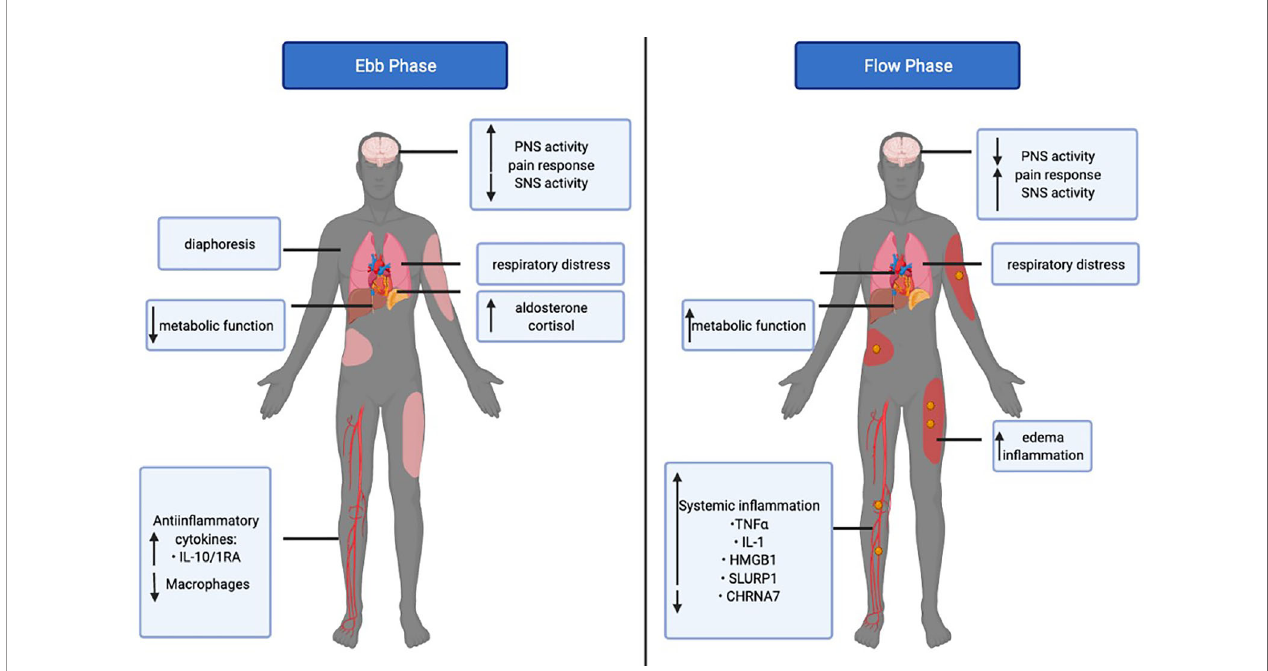
FIGURE 1 | The bi-directional communication between the central nervous system (CNS) and the spleen. The parasympathetic nervous system (PNS) uses acetylcholine and the vagus nerve to decrease burn-induced in fl ammation via the spleen. The sympathetic nervous system (SNS) uses norepinephrine and the hypothalamus, pituitary, and adrenal axis (HPA axis) to increase burn-induced in fl ammation via the spleen. In turn, the CNS is regulated by the cytokines released from the immune cells of the spleen in a negative feedback